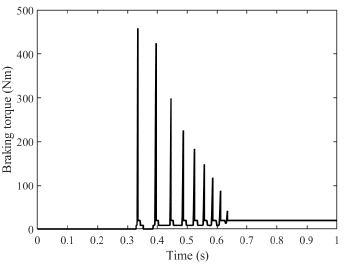
Figure 11. Dynamic features of friction pair under reverse load.